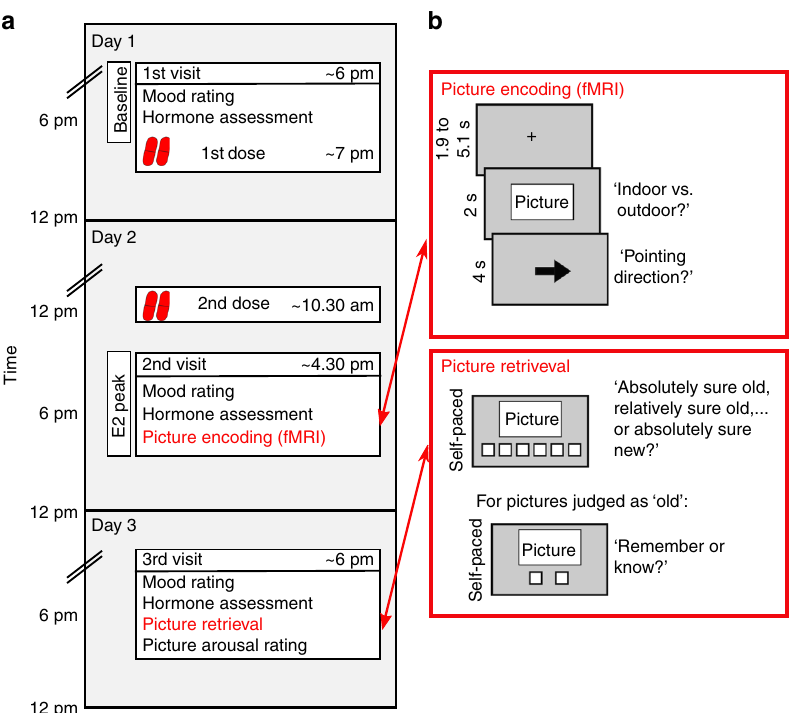
Fig. 1 Study design. a Volunteers participated in the study on three consecutive days. On the evening of Day 1, baseline hormone concentrations and mood were assessed, followed by the fi rst dose of either 17-beta-estradiol (E2; 2, 4, 6 or 12 mg) or placebo, depending on assigned group (double-blind). On the morning of Day 2, volunteers took the second dose on their own. In the afternoon of Day 2, when E2 levels were expected to peak, volunteers encoded emotional pictures inside the scanner ( b , upper red box). On the evening of Day 3, volunteers performed a recognition test ( b , lower red box) and rated the encoded pictures for arousal. See Supplementary Methods for more details on the timeline of the